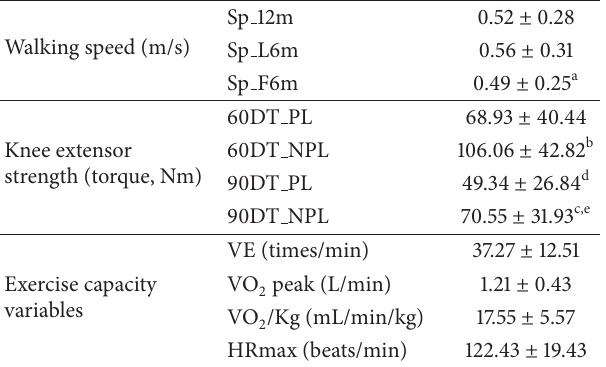
Table 3: Pearson’s correlation with walking speed and VO